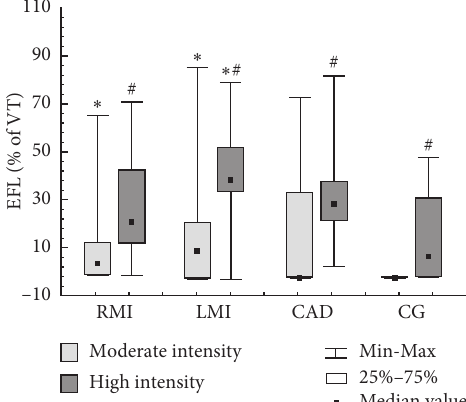
Figure 2: Degree of expiratory flow limitation at moderate and high intensity exercise. Data are presented as median ± (25%–75% and minimum–maximum). EFL, expiratory flow limitation; VT, tidal volume; RMI, recent myocardial infarction group; LMI, late myo- cardial infarction group; CAD, stable coronary artery disease group; CG, control group. ∗ Difference in relation to CG in the same intensity. # Difference in relation to moderate intensity exercise ( p < 0 . 05). The Kruskal–Wallis (Dunn post hoc) and Wilcoxon tests were